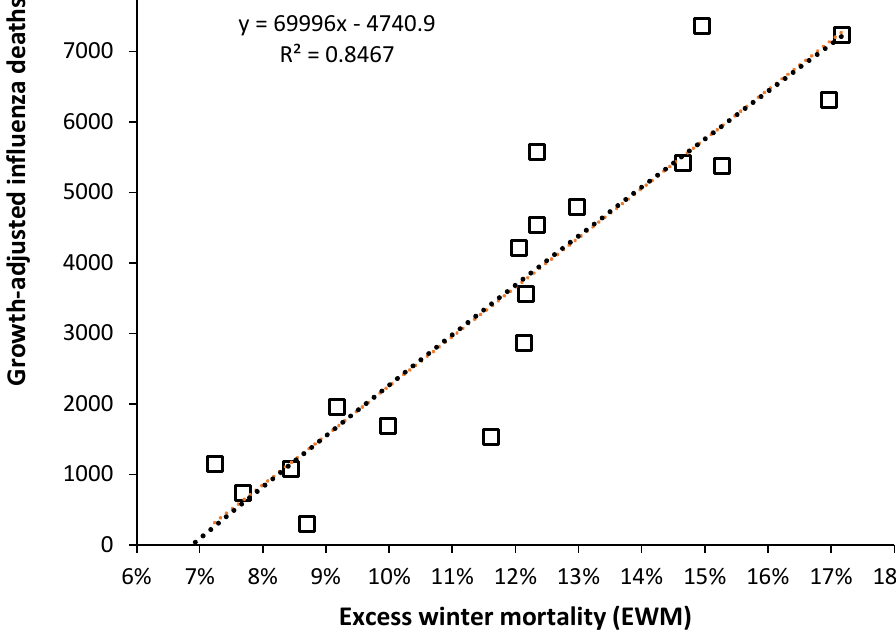
Figure A3. Relationship between estimated influenza deaths in Canada versus EWM, 1992–2009. Data is from the study of Schanzer et al. [50]. From 1992 to 2009 there was around 19% growth in deaths. Each year has been adjusted for underlying growth using a polynomial curve fit.